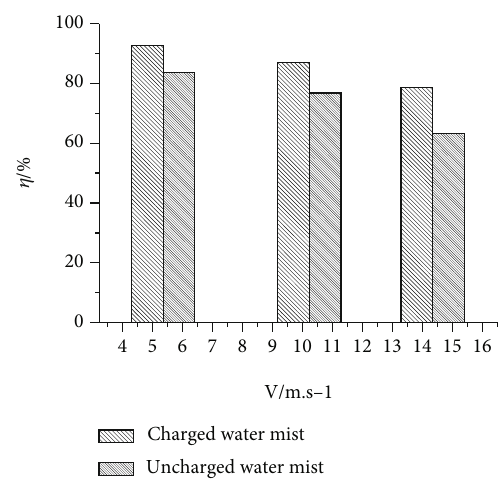
Figure 16: Charged and uncharged water mist e ff ect on respiratory dust removal e ffi